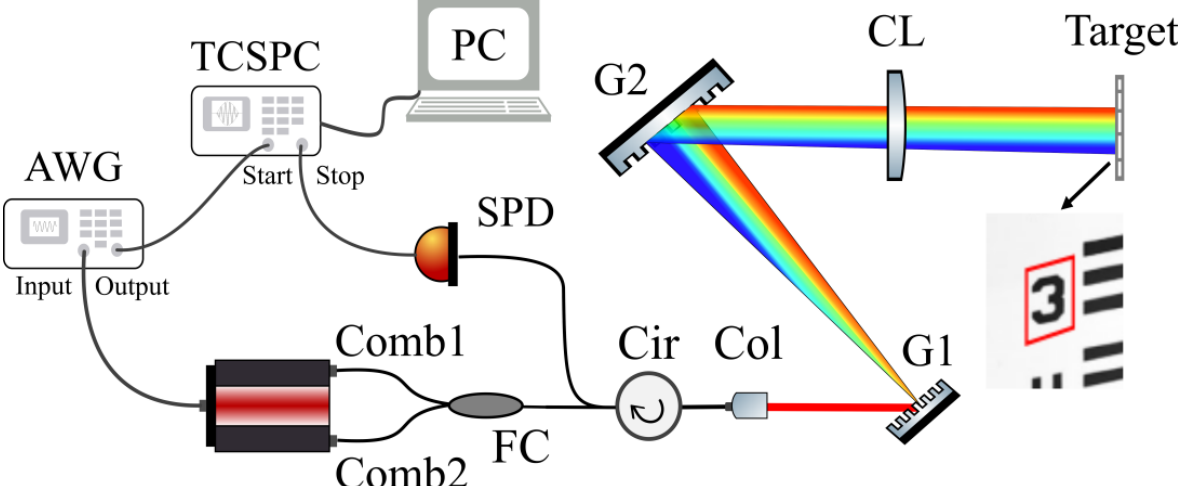
Figure 1. Experimental setup for the photon-counting dual-comb interferogram imaging. FC: 50:50 fiber coupler; Cir: fiber circulator; Attn: fiber attenuator; Col: collimator; G1, G2: a pair of reflective diffraction gratings with 600 lines/mm; CL: cylinder lens; SPD: single-photon detector; AWG: arbitrary waveform generator; TCSPC: time-correlated single-photon counter; Target: Positive 1951 USAF target marked with a red box as the laser illuminated area; PC: computer.